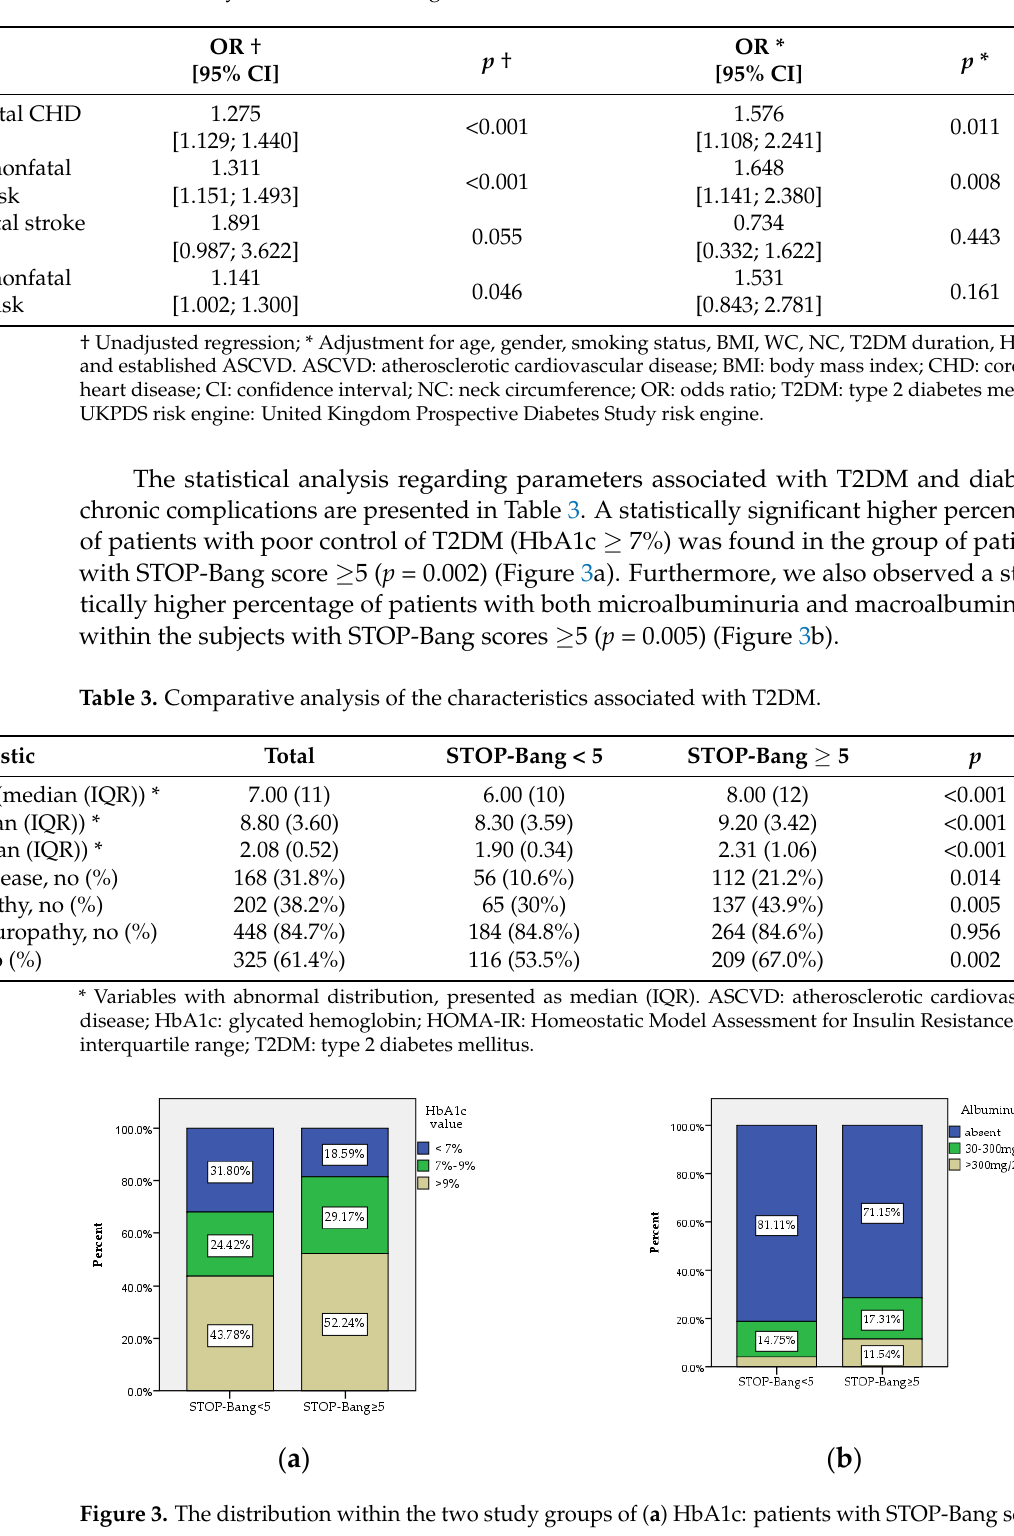
Table 2. Logistic regression for the association of STOP-Bang score ≥ 5 with 10-year cardiovascular risk assessed by the UKPDS risk engine.